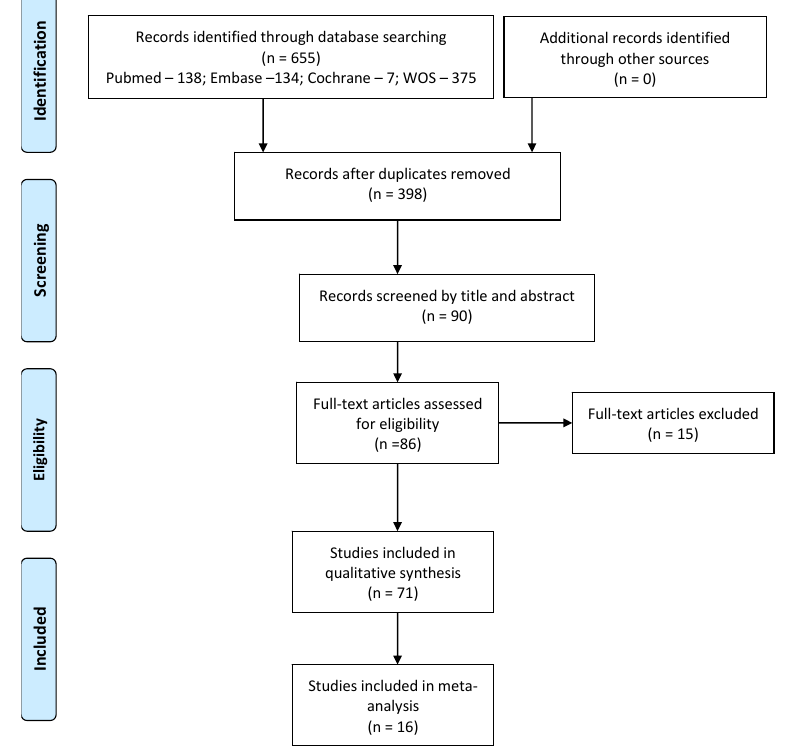
Figure 1. PRISMA flow diagram of studies selection.